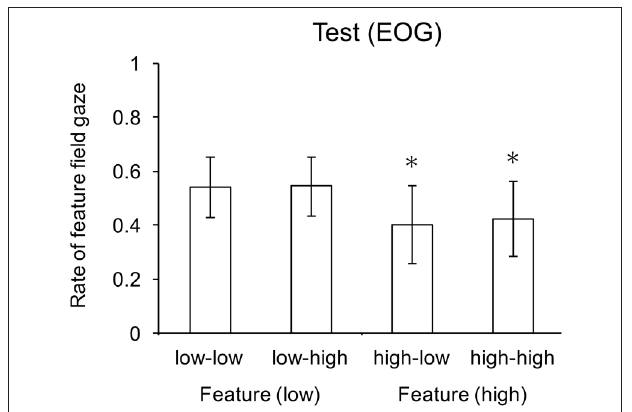
FIGURE 3 | Mean gaze rates to the feature search field. Whiskers indicate one standard deviation, and * indicates means significantly lower than